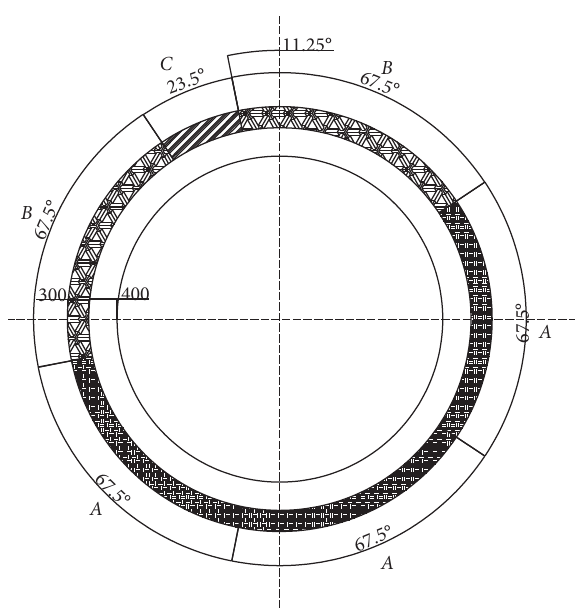
Figure 3: Schematic diagram of composite lining for water con- veyance